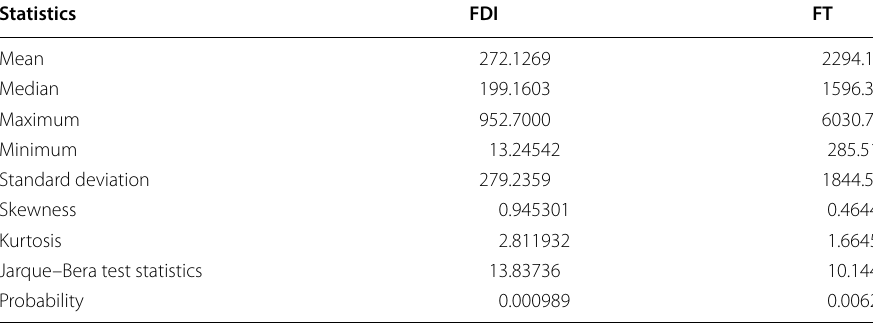
Table 1 Descriptive statistics. Source: Calculated by authors